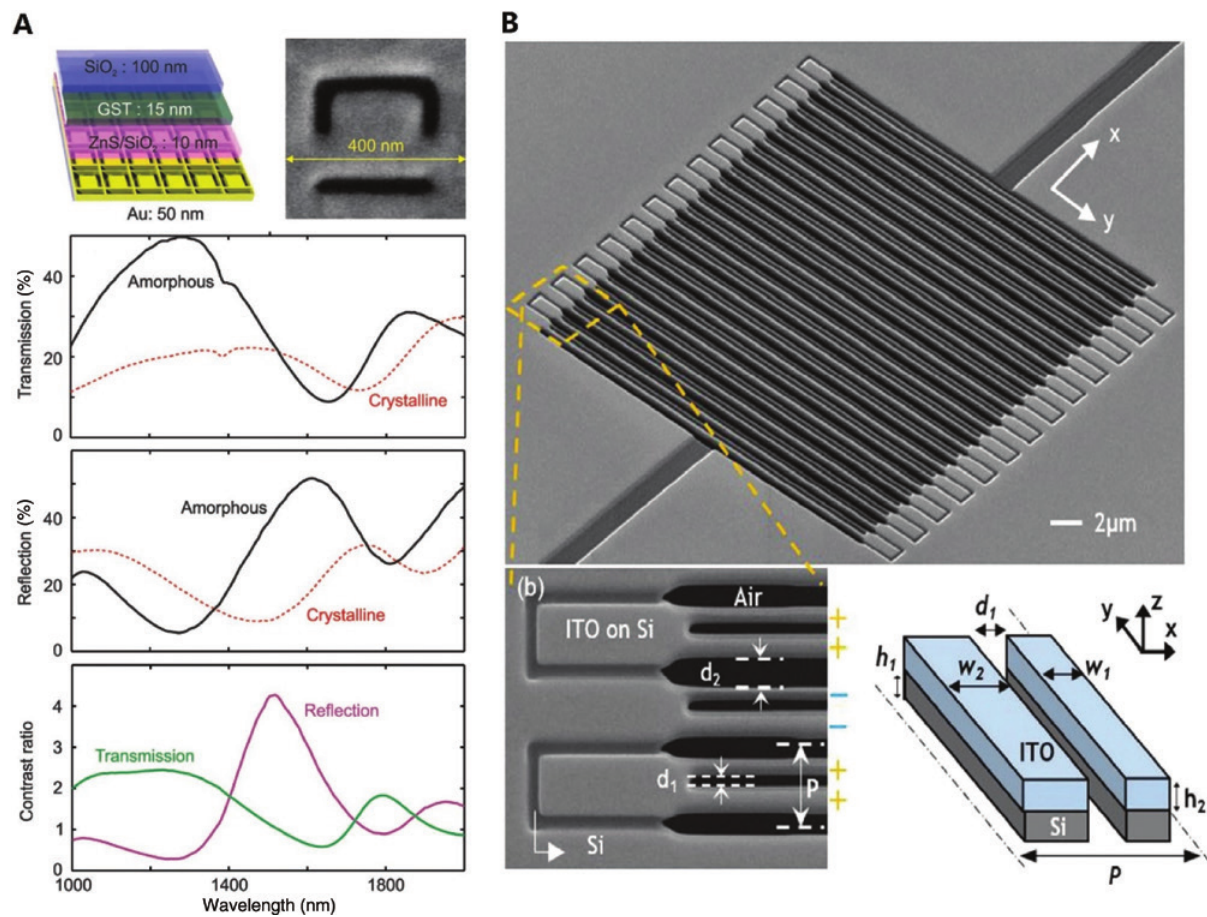
Figure 5: Other novel materials for constructing PIT structures. (A) Schematic of a multilayer structures with all-optical and nonvolatile tunability. The SEM image indicates that the structure owns a subwavelength unit cell and the GST is introduced as a phase-changed material. By changing the GST from amorphous to crystalline phase, the transparent window can be tuned with a high contrast ratio [118]. (B) SEM images of an artificial metamaterial nanostructure comprising arrays of subwavelength nanowires made of ITO on silicon. Under the application of an applied electric field, the structure can be reversibly structurally deformed due to electrostriction [119]. (a) Reproduced with permission from Ref. [118]. Copyright 2013 Wiley. (b) Reproduced with permission from Ref. [119]. Copyright 2019